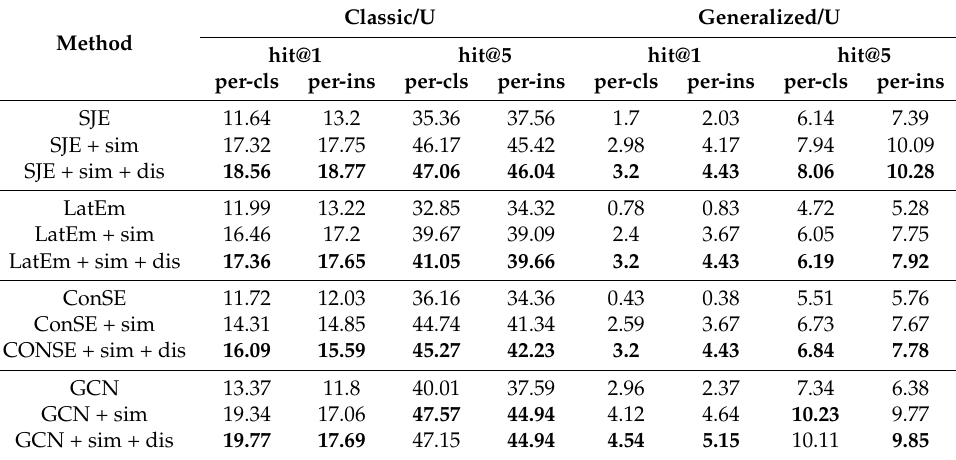
Table 4. An ablation study on HM path